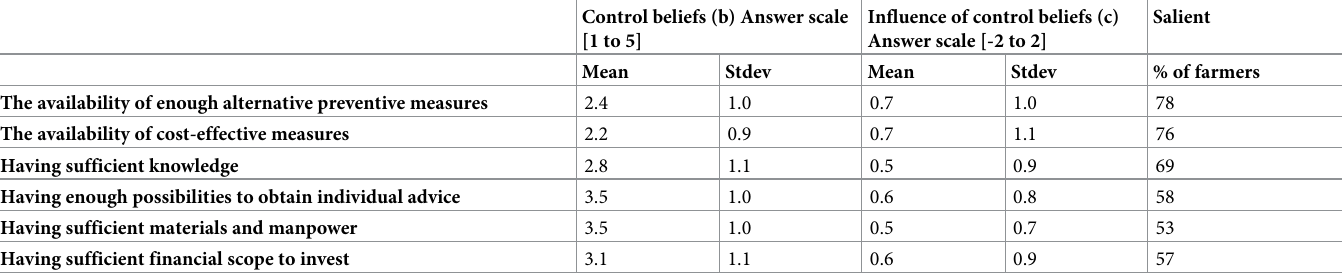
Table 4. Average score for perceived behavioural control (PBC) beliefs and the percentage of farmers for which the belief is salient (n = 85).